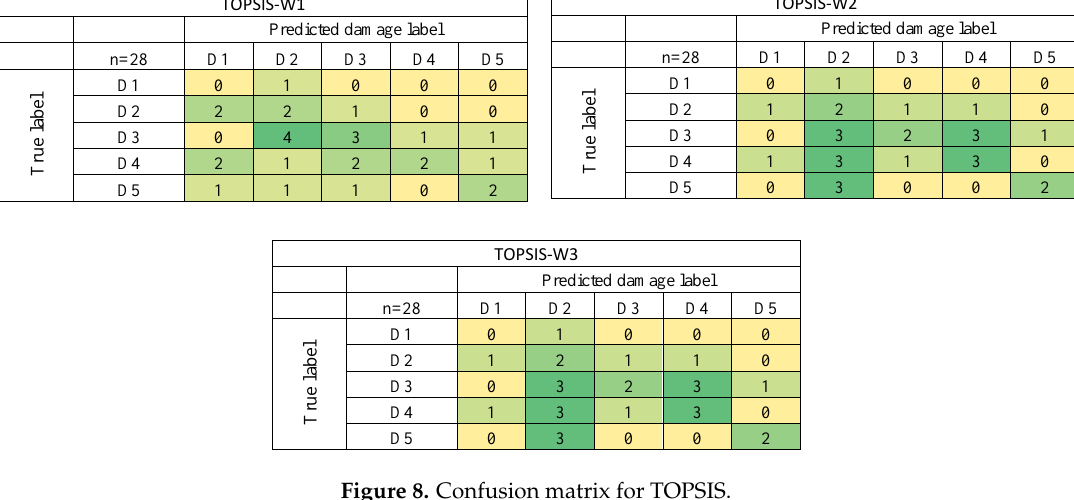
Figure 8. Confusion matrix for TOPSIS.